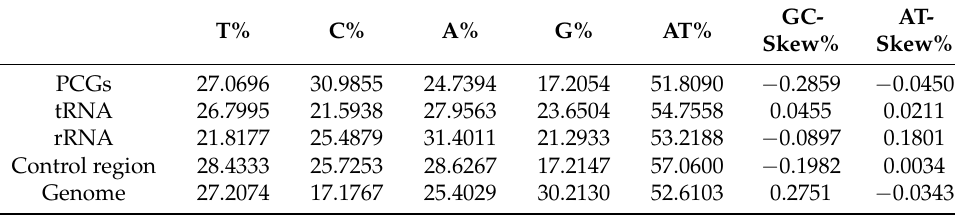
Table 3. Nucleotide composition and strand asymmetry of the P. dentex mitochondrial